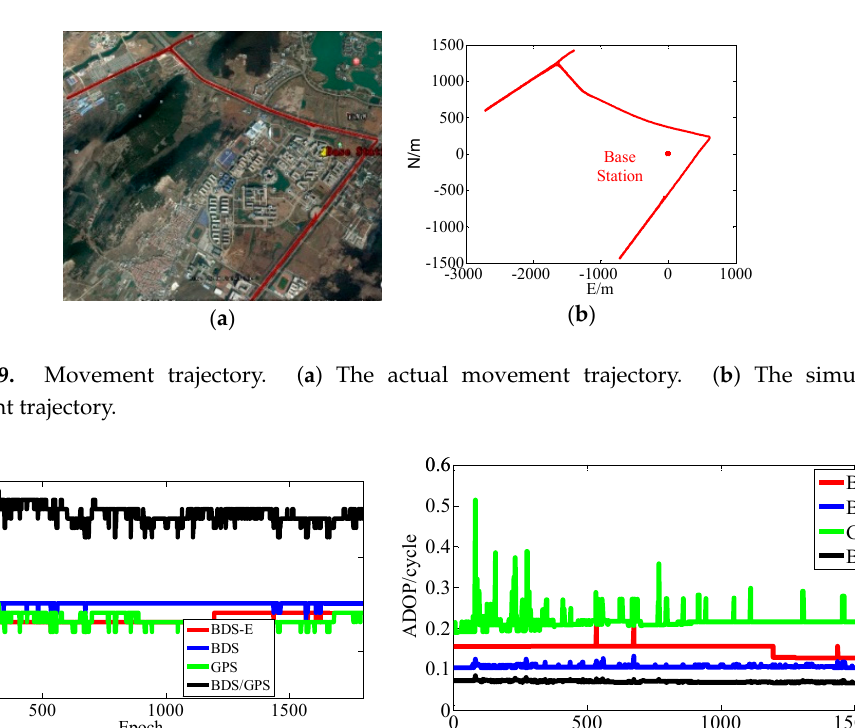
Figure 20. Satellite number and ADOP of four systems. ( a ) The satellite number of four systems. ( b ) The ADOP of four systems.